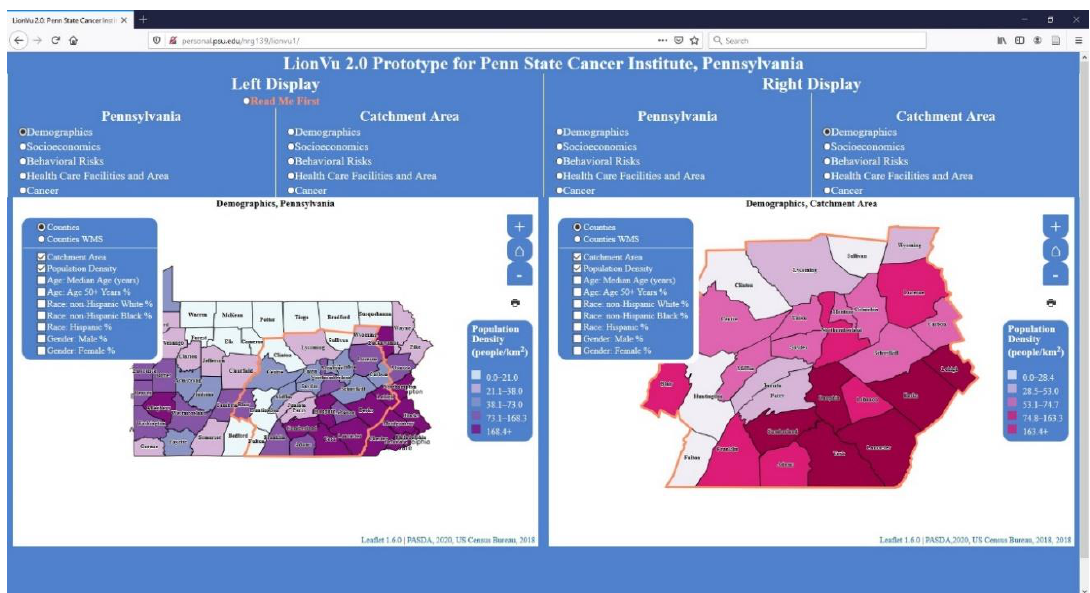
Figure 2. LionVu 2.0 used in usability assessment. Left Display: population density (people/km 2 ) within Pennsylvania. Right display: population density (people/km 2 ) within catchment area. Layer list was not collapsed in order to clarify what fields were available for selection.